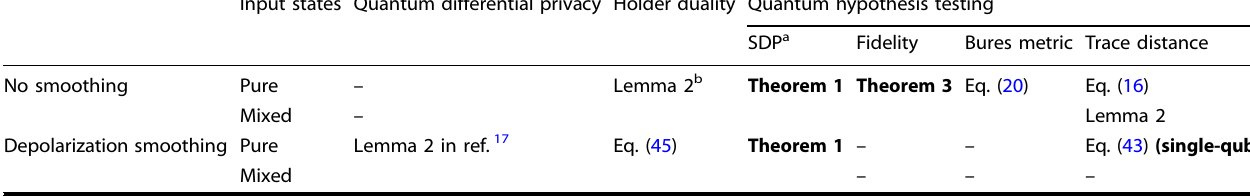
Table 1. Summary of